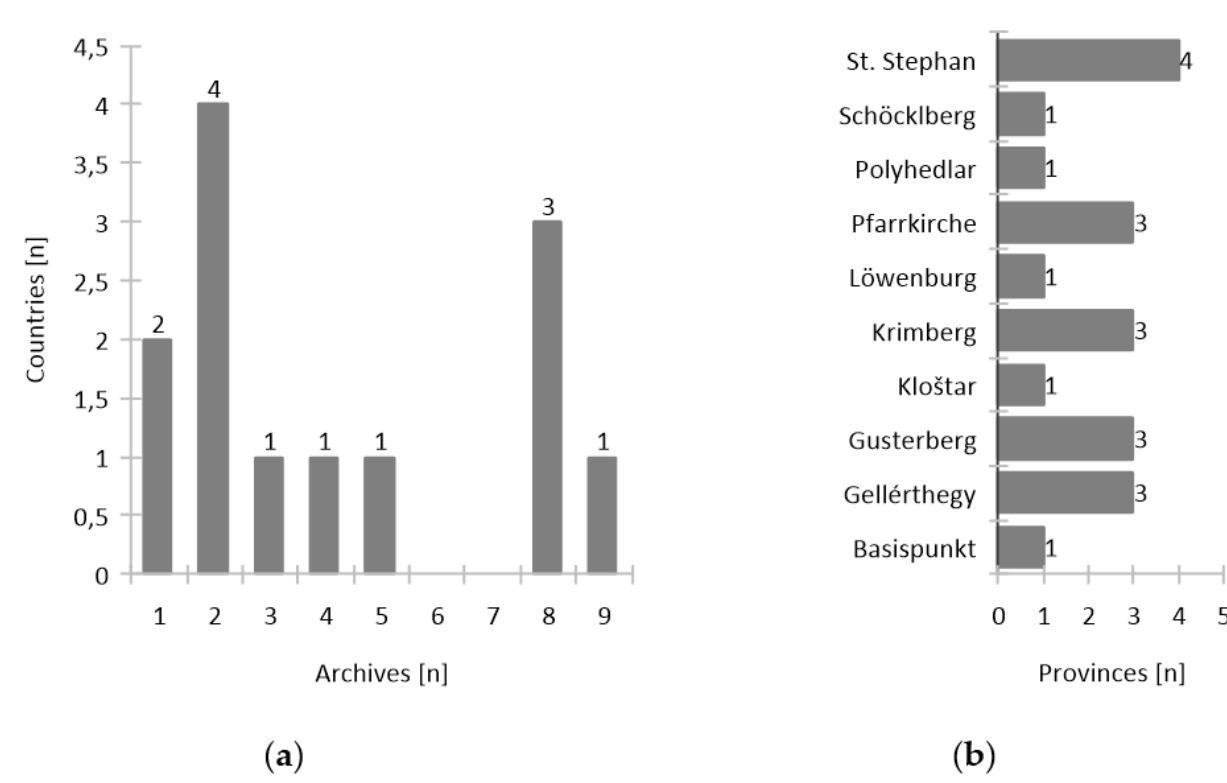
Figure 3. ( a ) Number of countries for each number of archives. ( b ) Number of provinces for each coordinate system. Source: Own compilation.